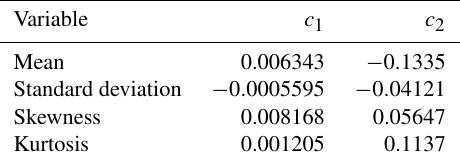
Table 1. Parameter values for Eq. (10) for the monthly mean, stan- dard deviation, skewness and kurtosis of the surface